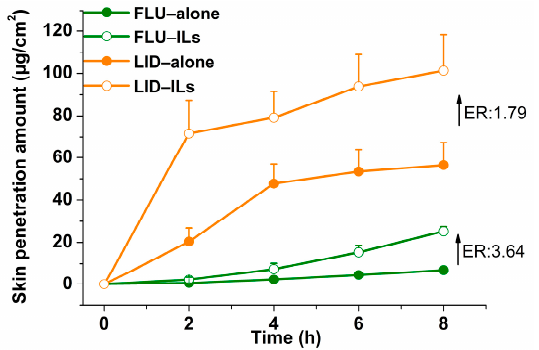
Figure 4. The skin permeability of FLU, LID and ILs ( n = 4).